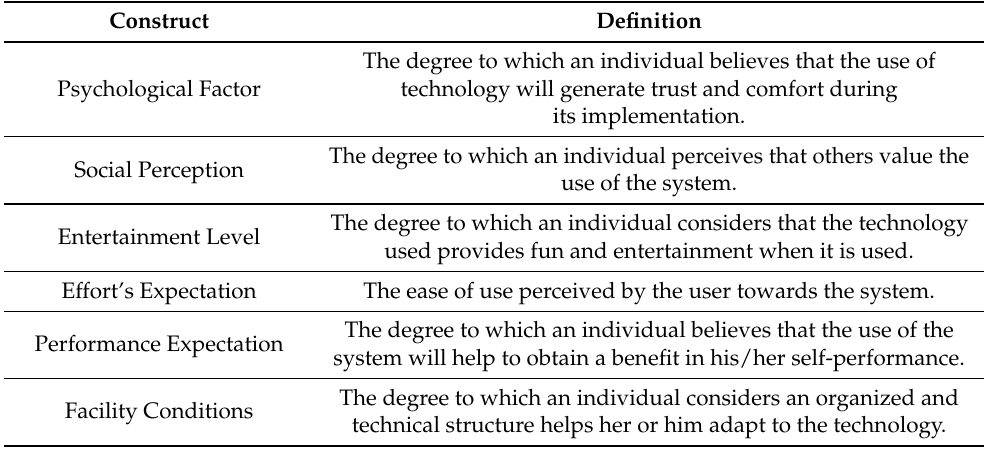
Table 2. UTAUT constructs